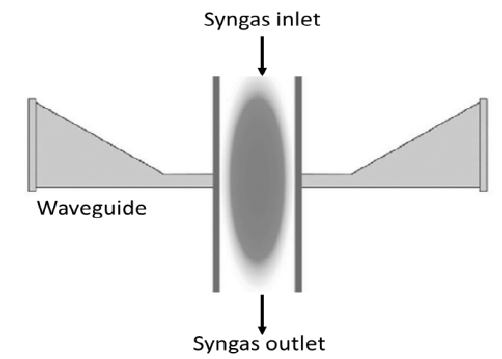
Figure 3. Schematic representation of an MWD.